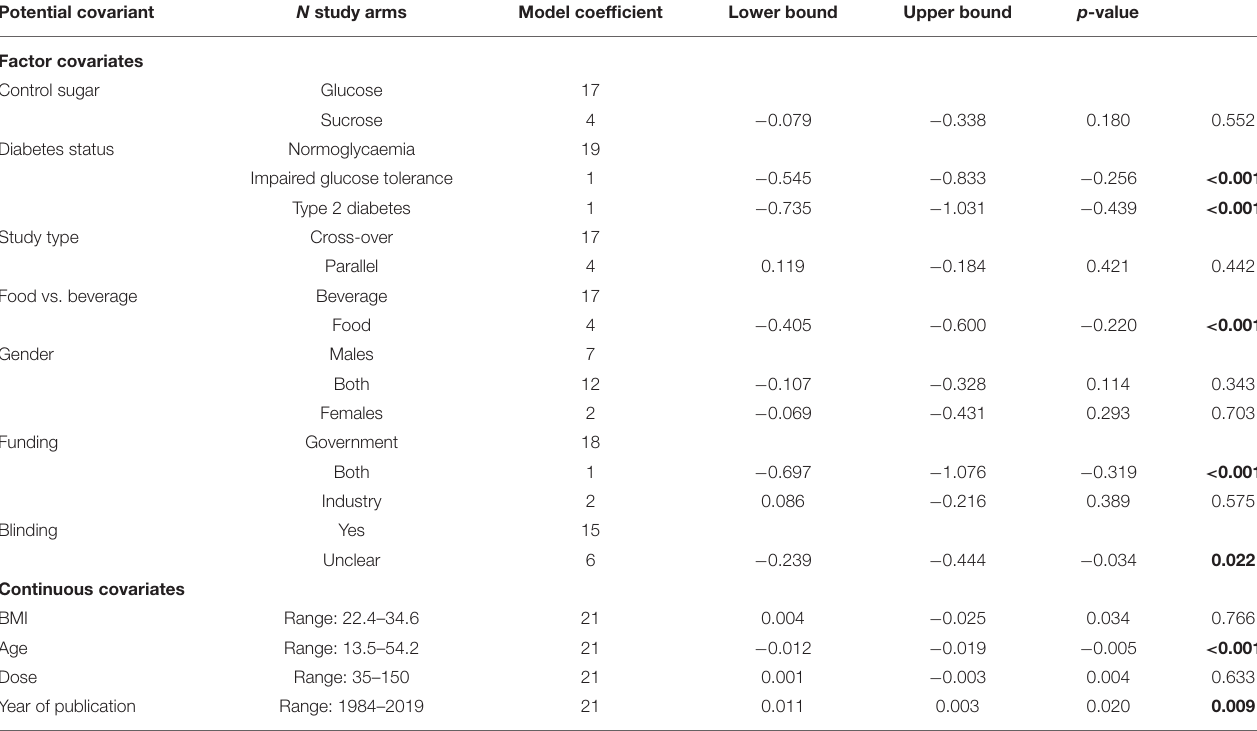
TABLE 2 | Meta-regression of mean differences in fasting blood glucose concentrations between consumption of fructose compared with sucrose or glucose by factor and continuous covariates. Potential